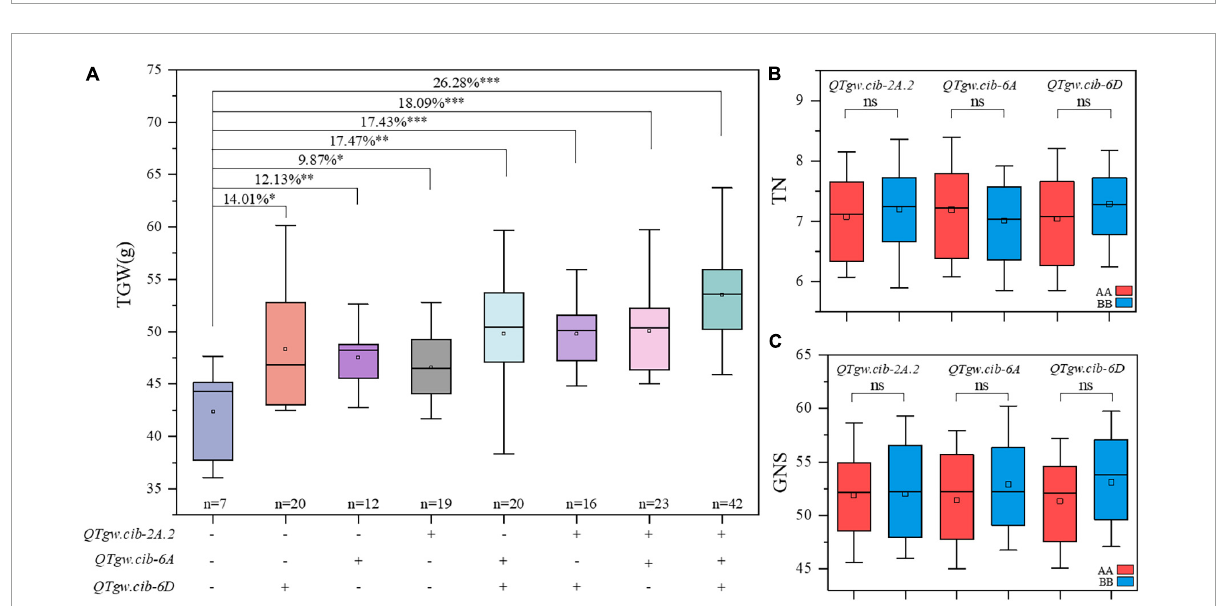
FIGURE3 Pyramiding effect analysis of QTgw.cib-2A.2 , QTgw.cib-6A and QTgw.cib-6D on TGW (A) , TN (B) , and GNS (C) . ∗ , ∗∗ , and ∗∗∗ represent significance at P < 0.05, P < 0.01, and P < 0.001, respectively and ns represents non-significance; + and - represent lines with and without the positive alleles of the target QTLs based on the flanking markers of the corresponding QTL, respectively; AA and BB represent lines with and without the positive alleles of the target QTLs based on the flanking markers of the corresponding QTL, respectively.